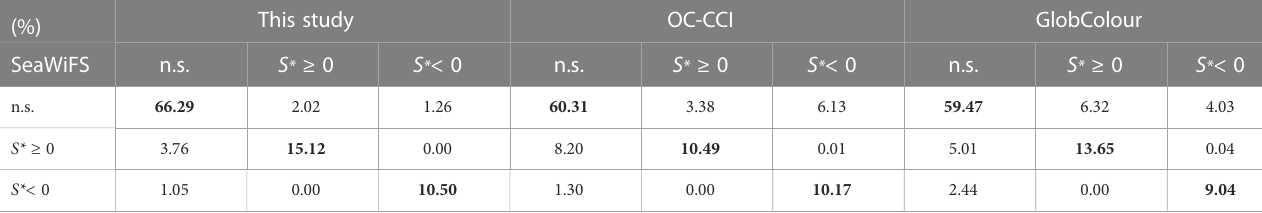
TABLE 1 Contingency matrices comparing trend analysis outcomes for SeaWiFS period.